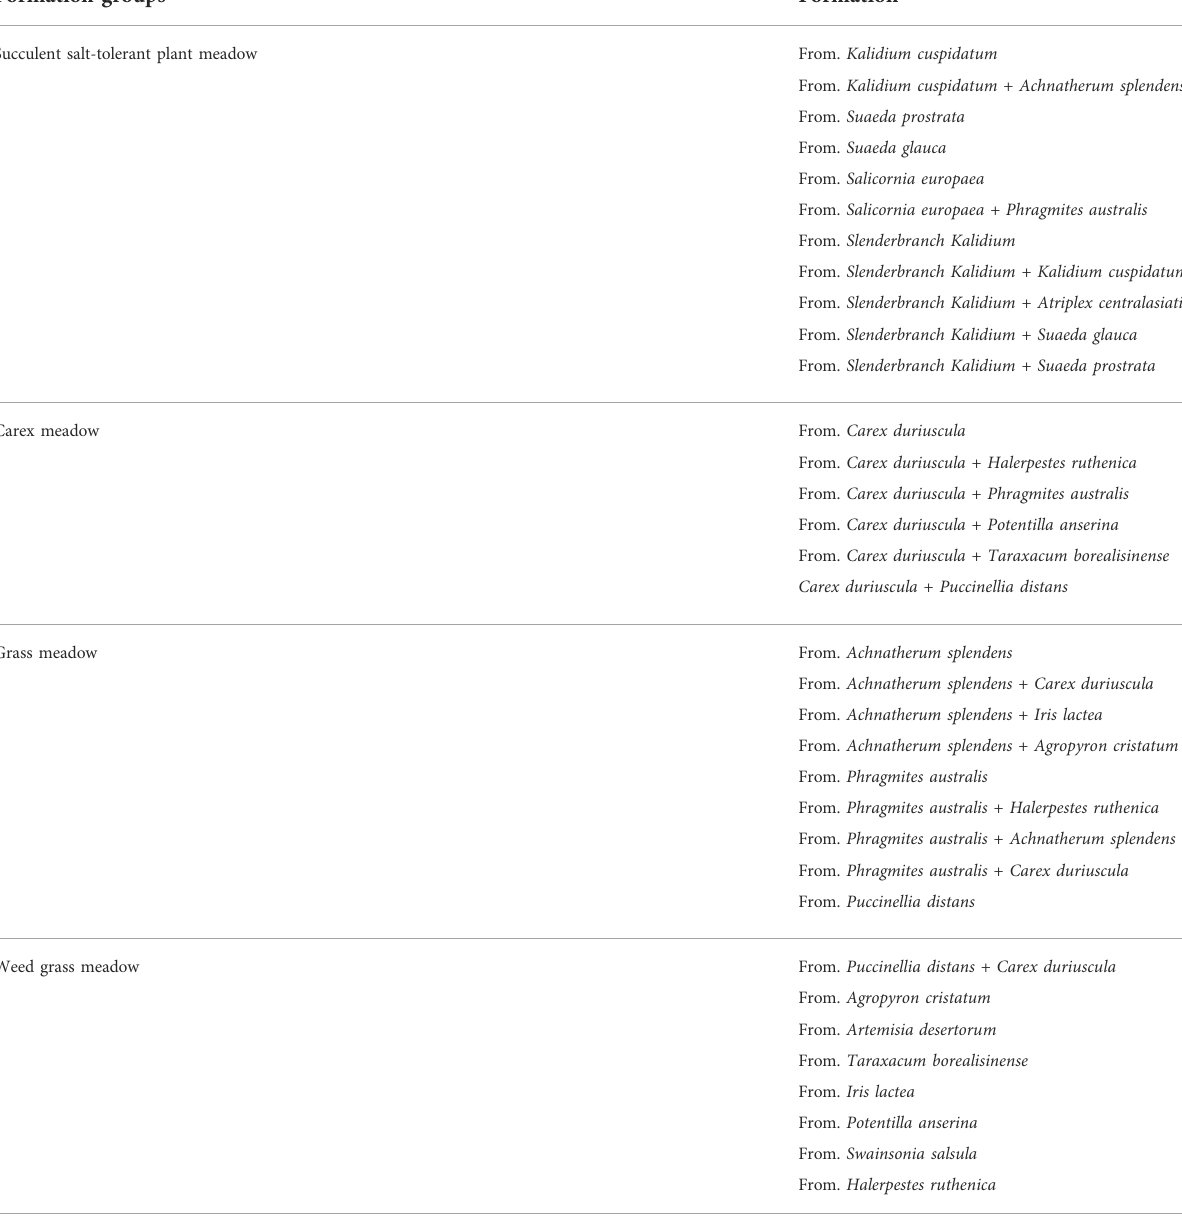
TABLE 2 Composition of vegetation formations in the study area.